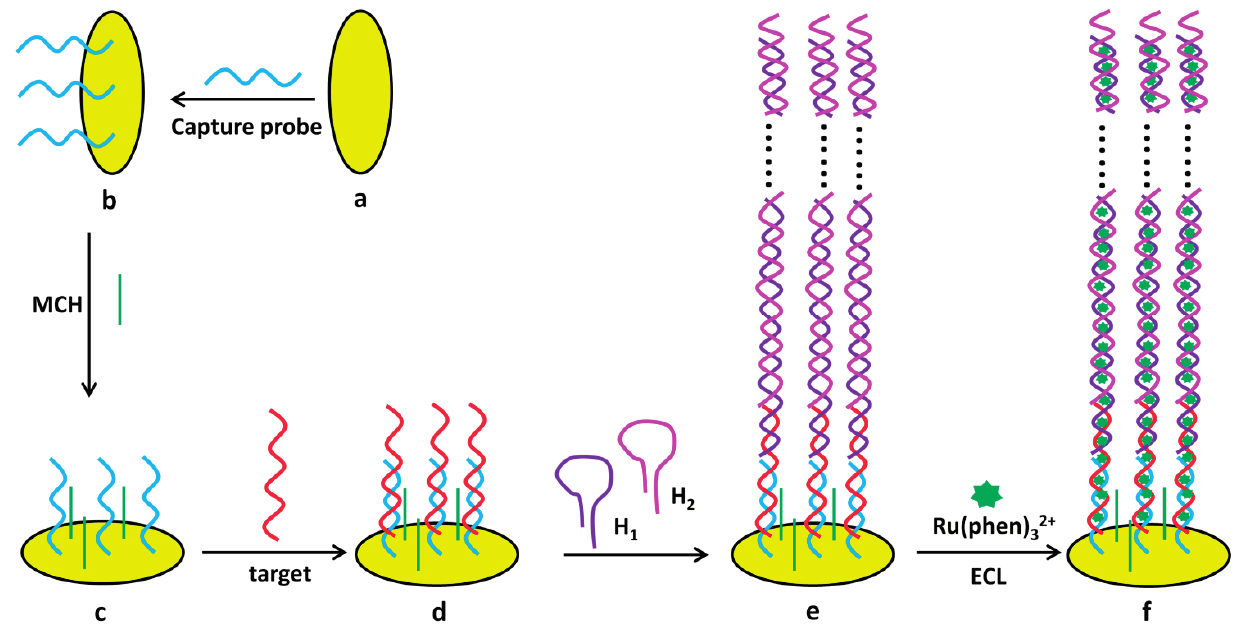
Figure 14. ECL DNA detection using as Ru(phen) 32+ as ECL luminophore. The signal was amplified through in situ hybridization chain reaction. MCH, mercaptohexanol. Reprinted with permission from ref. [187], copyright (2012) American Chemical